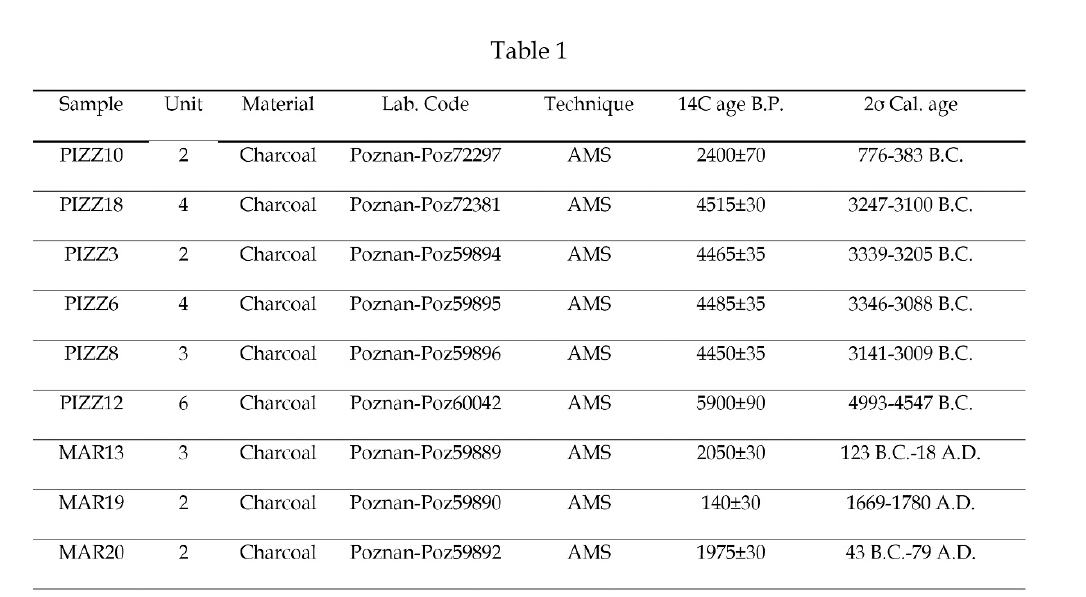
Table 1: Measured and dendrochronologically calibrated 14C age of samples collected in the trenches. Sample lo- cation and age are shown in Figures 5 and 6.